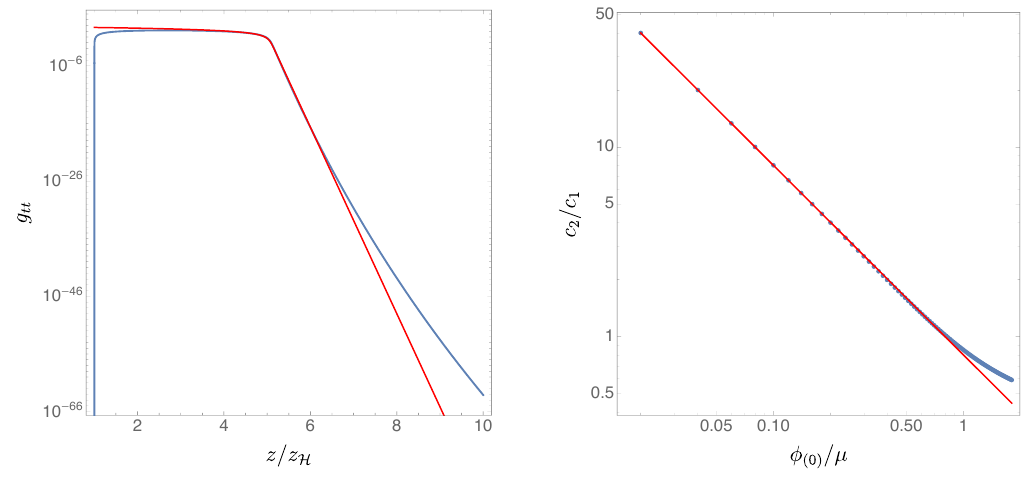
Figure 4 . Collapse of the Einstein-Rosen bridge. Left: abrupt crossover of g tt at the would-be inner horizon. Blue line is from a numerical solution of the equations of motion and the red line is a (cid:12)t to the analytic crossover form (4.3). Right: (cid:12)t parameter c 2 =c 1 as a function of the boundary value of the scalar deformation. As the deformation becomes small, c 2 =c 1 becomes large and the crossover more dramatic. Blue dots are numerical data points and the red line shows c 2 =c 1 (cid:25) 0 : 8 (cid:22)=(cid:30) All data shown for temperature T=(cid:22) (cid:25) 0 : 2188 and a scalar (cid:12)eld with m 2 = (cid:0) 2. Left plot has (cid:30) =(cid:22) (cid:25) 0 : 2193, corresponding to c 2 =c 1 (cid:25) 3 : (0)